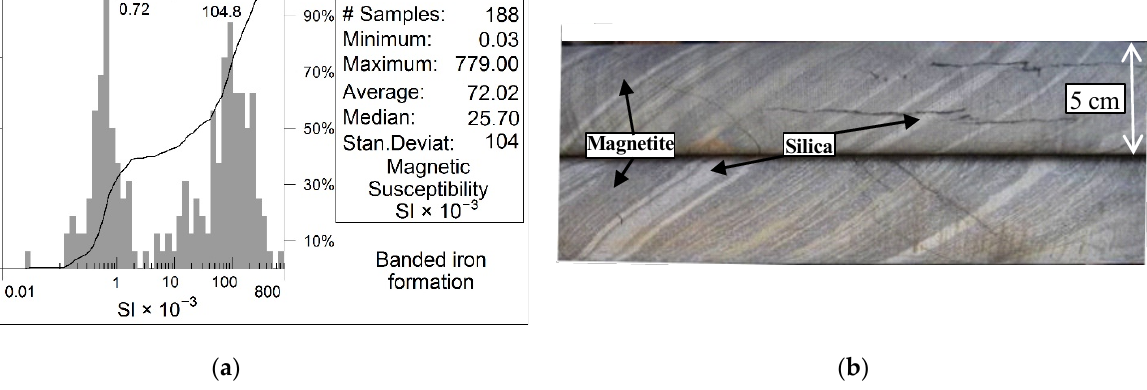
Figure 13. Banded iron formation. ( a ) Statistics and histogram of the magnetic susceptibility measurements. ( b ) Core samples picture.